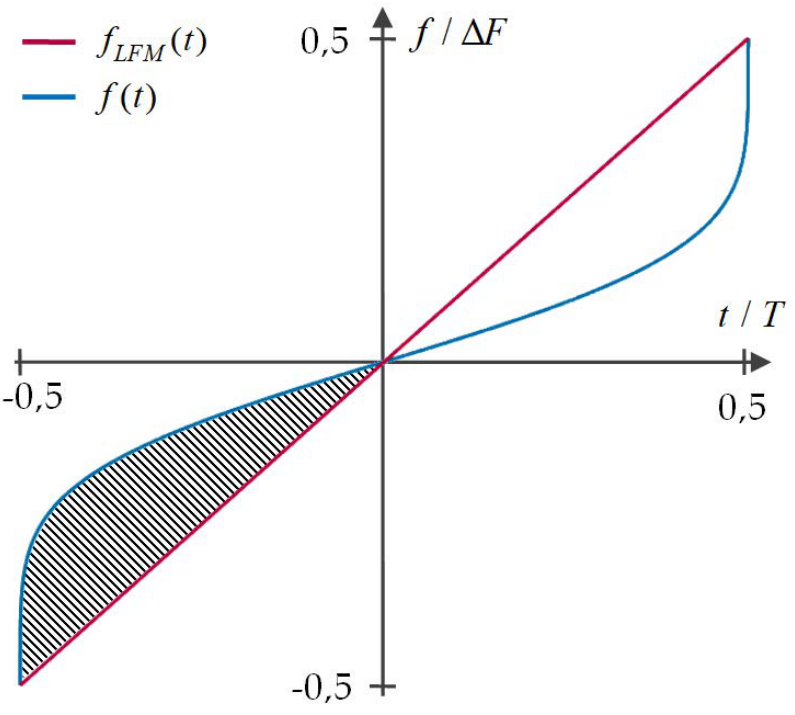
Figure 2. Illustration of nonlinearity factor (in above case η = 0.57).